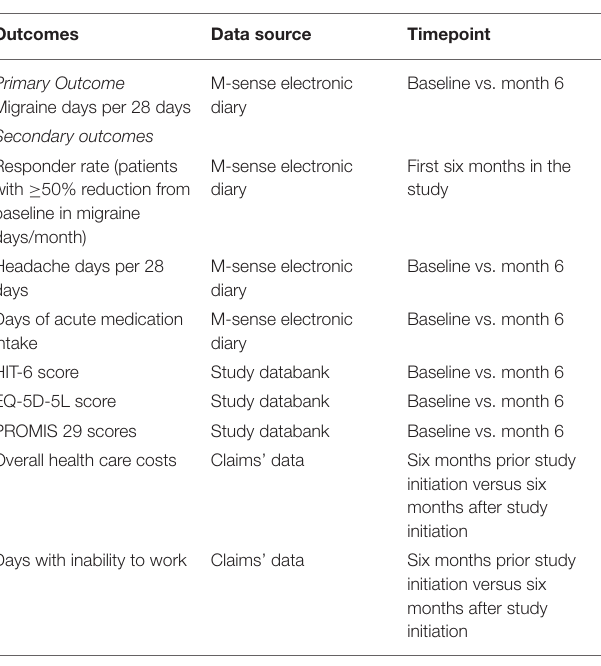
TABLE 1 | Study outcomes and data collection